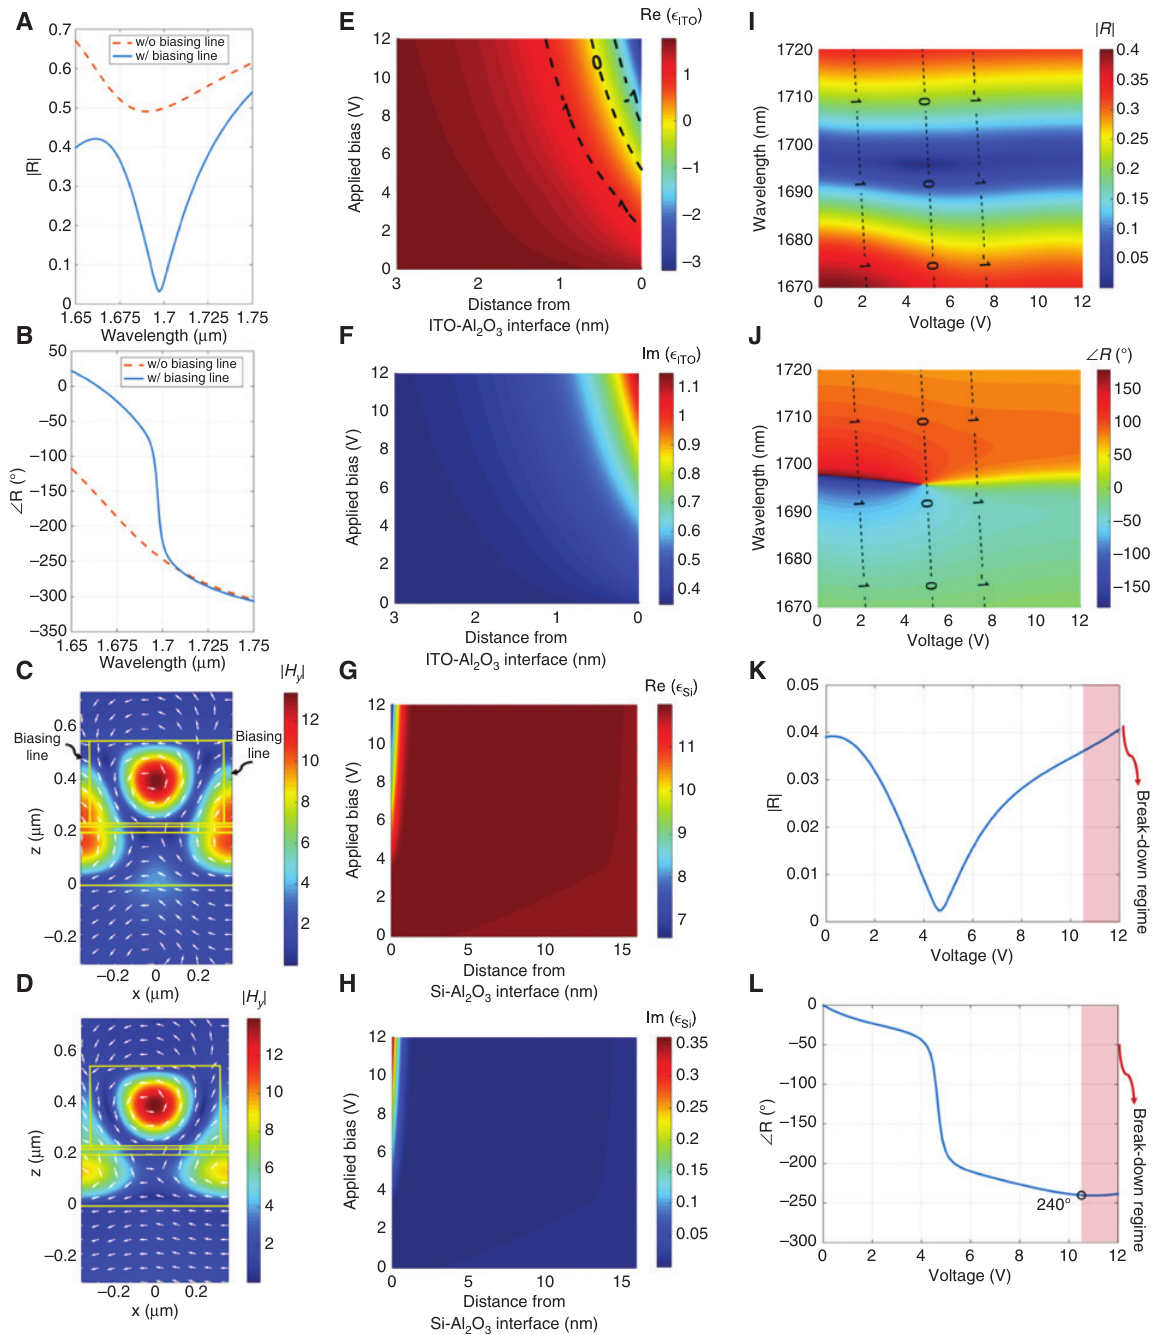
Figure 2: Optical performance of the dual-mode ITO-integrated metasurface unit cell in reflection mode. Reflection (A) amplitude and (B) phase of the proposed ITO-integrated metasurface illuminated by x -polarized incident beam for the unbiased case in the presence (solid blue lines) and absence (dashed red lines) of the biasing lines. The near-field spatial distributions at the resonant wavelengths of (C) 1696 nm and (D) 1691 nm in the presence and absence of biasing lines, respectively. The color bar shows the y -component of the magnetic field (| H |), and the white arrows are related to the normalized electric displacement currents at the x - z y plane. The location of the Si nanobars, which serve as biasing lines, is annotated in (C). (E–H) The real and imaginary parts of ITO and Si permittivities within their corresponding active layers at an operating wavelength of 1696 nm as functions of applied bias voltage and distance from their interfaces with Al O . The region denoted by dashed lines in (E) corresponds to the ENZ region within the ITO active layer. 2 3 (I, J) Color maps of reflection amplitude and phase as functions of voltage and wavelength. The dashed lines denote the points for which the real part of ITO permittivity, Re{ ε }, at the ITO-Al O interface is equal to −1, 0, and 1. Reflection (K) amplitude and (I) phase versus external ITO 2 3 applied voltage at an operating wavelength of λ Refl ≈ 1696 nm. The dielectric breakdown of the insulator occurs for the applied bias values higher than 10.5 V depicted by shadowed regimes in (K,